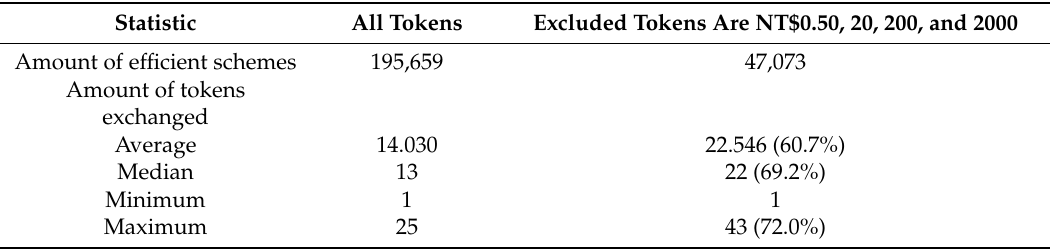
Table 1. Results for New Taiwan Dollar on efficient payment schemes (percentage increase, relative to the all tokens case) in